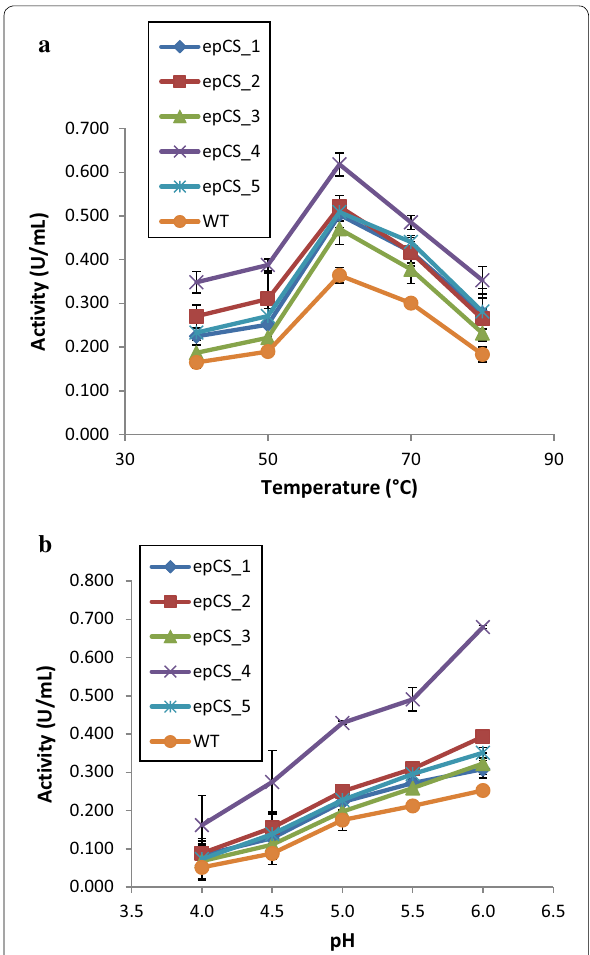
Fig. 1 Temperature ( a ) and pH ( b ) dependence of endo-glucanase activity for wild-type CelStrep and mutants. For the optimal temperature endo-glucanase activity was measured at pH 6 and temperatures ranging from 40 to 80 °C, using AZO-CMC as substrate. For the optimal pH determination, the endo-glucanase activity was measured in Na acetate buffer at pH ranging from 4 to 6, using AZO- CMC as